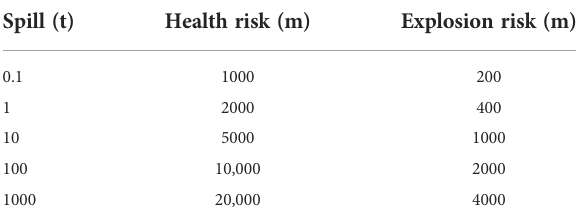
TABLE 5 Estimated extents of the health risk and explosion risk in the downwind direction for different quantities of gases spilled. (adopted from IMO/UNEP, 2009).